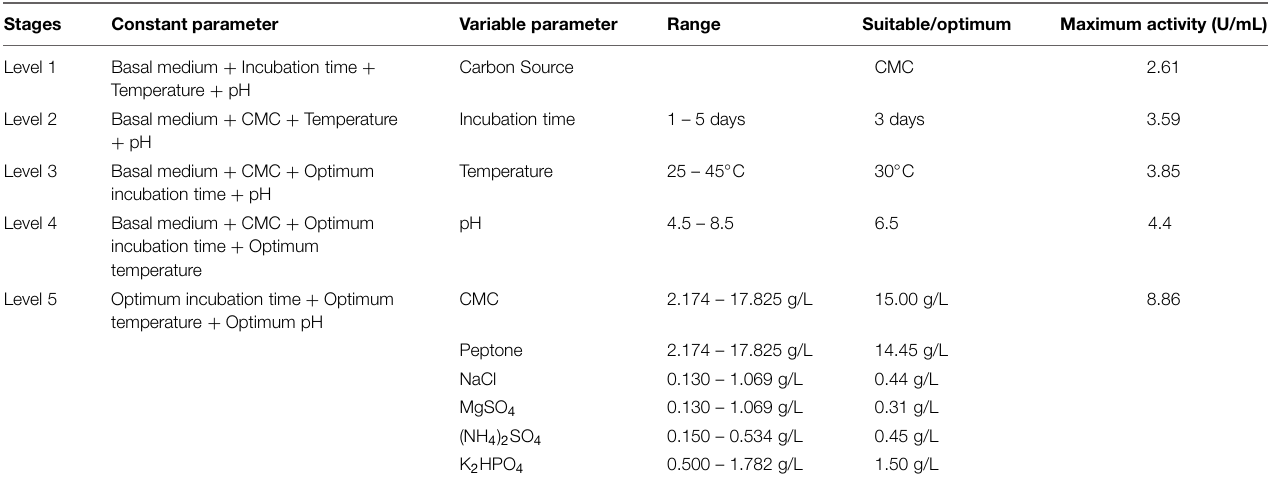
TABLE 4 | Successive levels of experiments and achieved enhancement in cellulolytic potential of strain